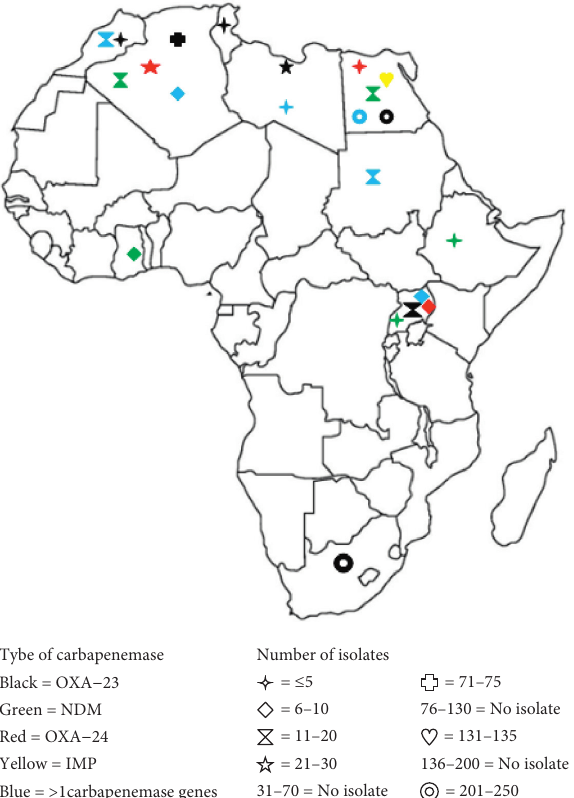
Figure 8: Geographical distribution of CPAB isolates in Africa from 2007 to 2017